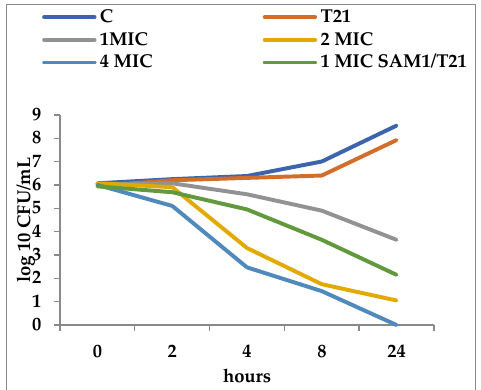
Figure 2. Effect of T21 (0,5%), SAM1 (1-4 MIC, and its association with T21 (SAM1 1MIC + T21) on the time-killing dynamics in S. aureus ATCC 33952.